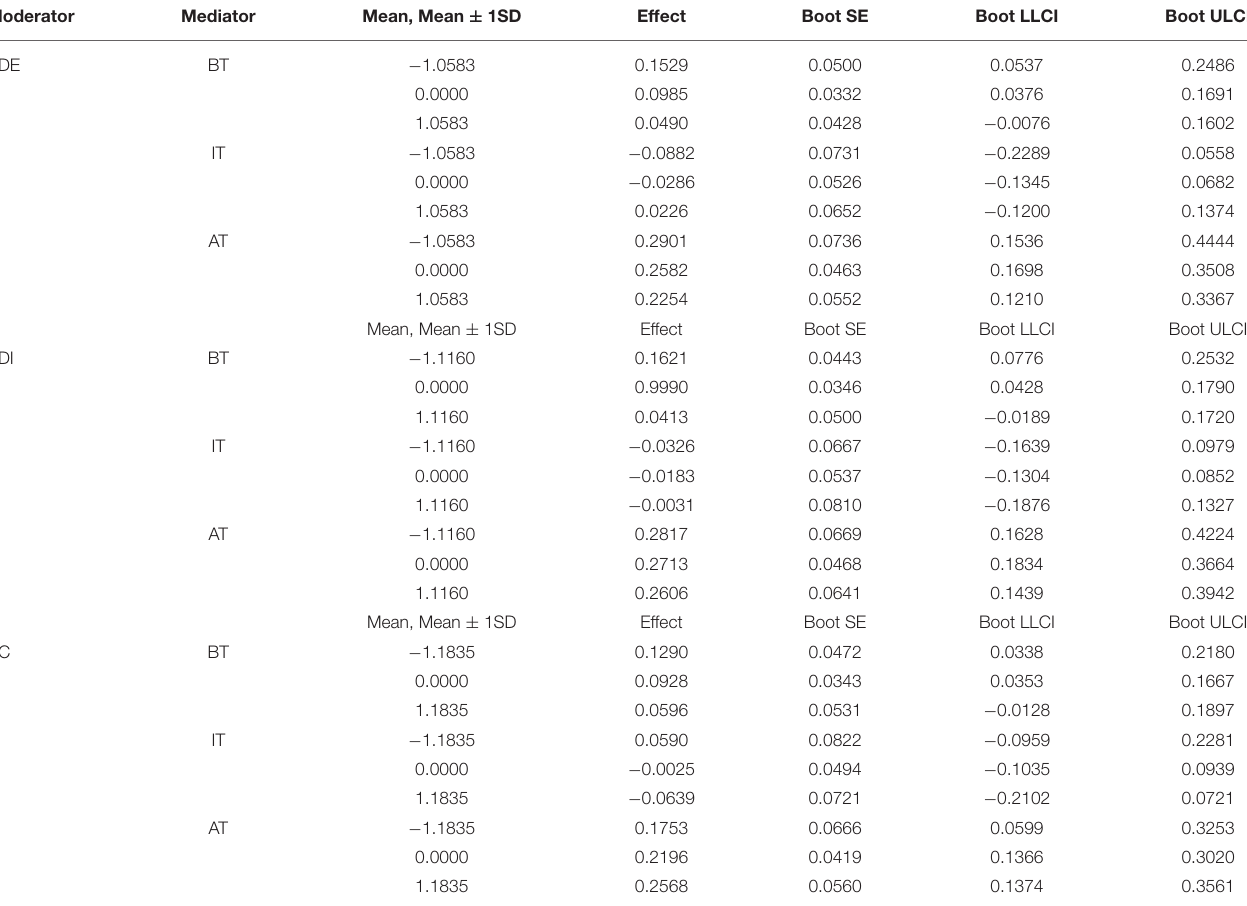
TABLE 6 | Results for the moderated mediation effects ( N = 406). Moderator